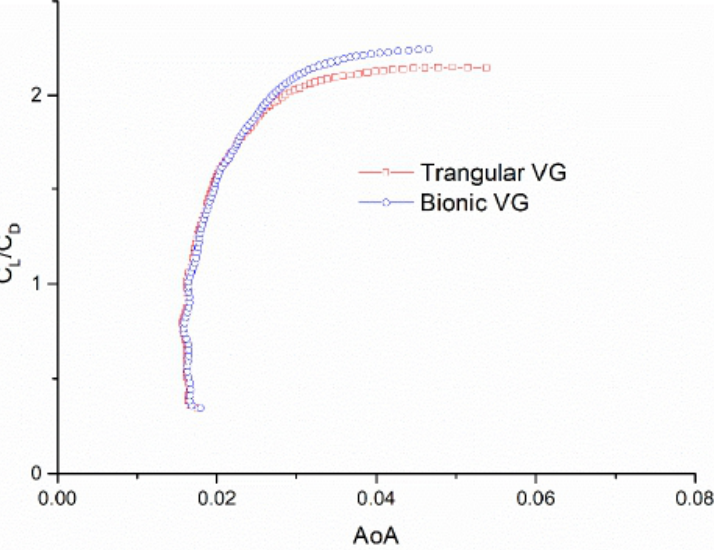
Figure 11. Blade lift coefficient of vortex generators with different shapes.